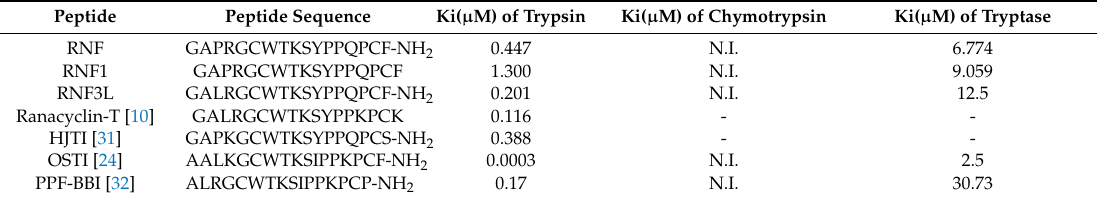
Table 1. Inhibitory activity of RNF, RNF1, RNF3L and some ranacyclins against trypsin, chymotrypsin and tryptase.